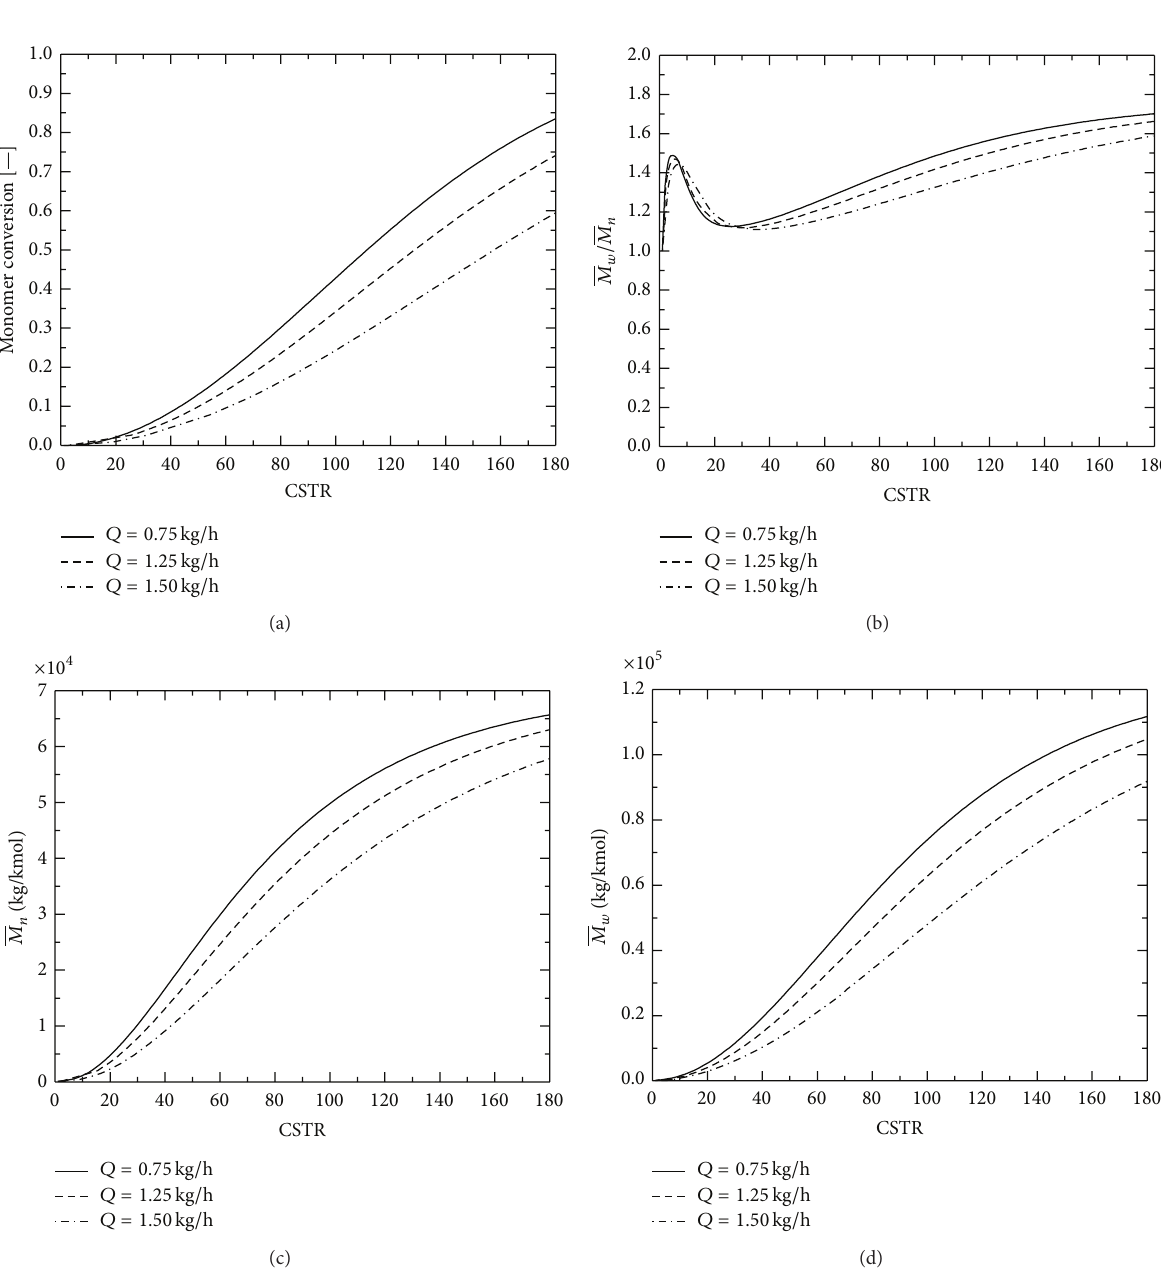
𝑀 𝑇 = 190 ∘ C, 𝑀 /𝐼 = 2250 , and rpm = 𝑤 , at 0 0